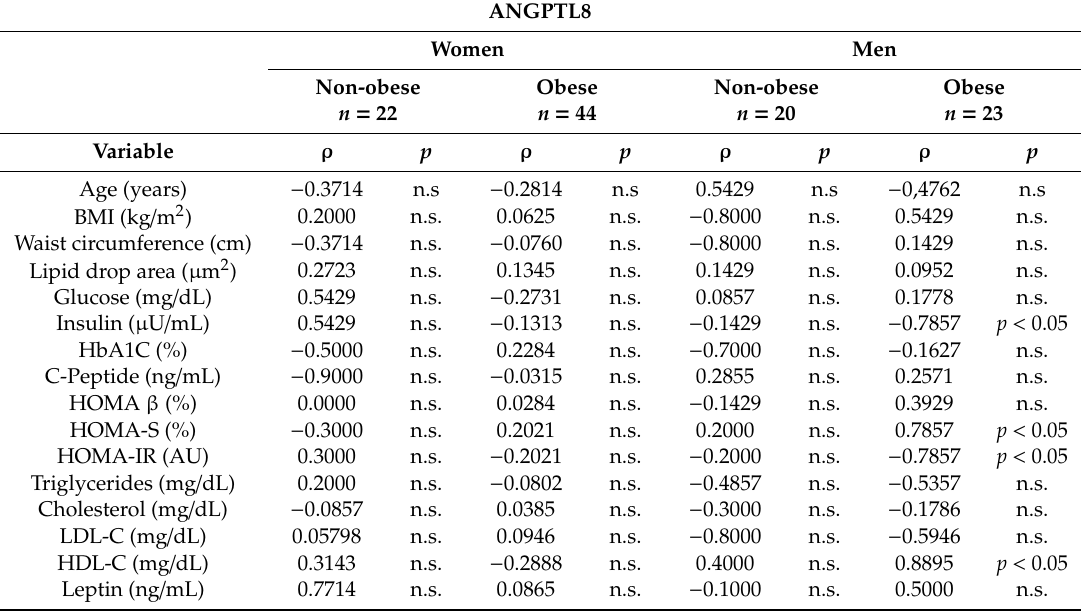
Table 3. Spearman’s correlation analyses regarding ANGPTL8 and anthropometric and clinical variables in non-obese and obese